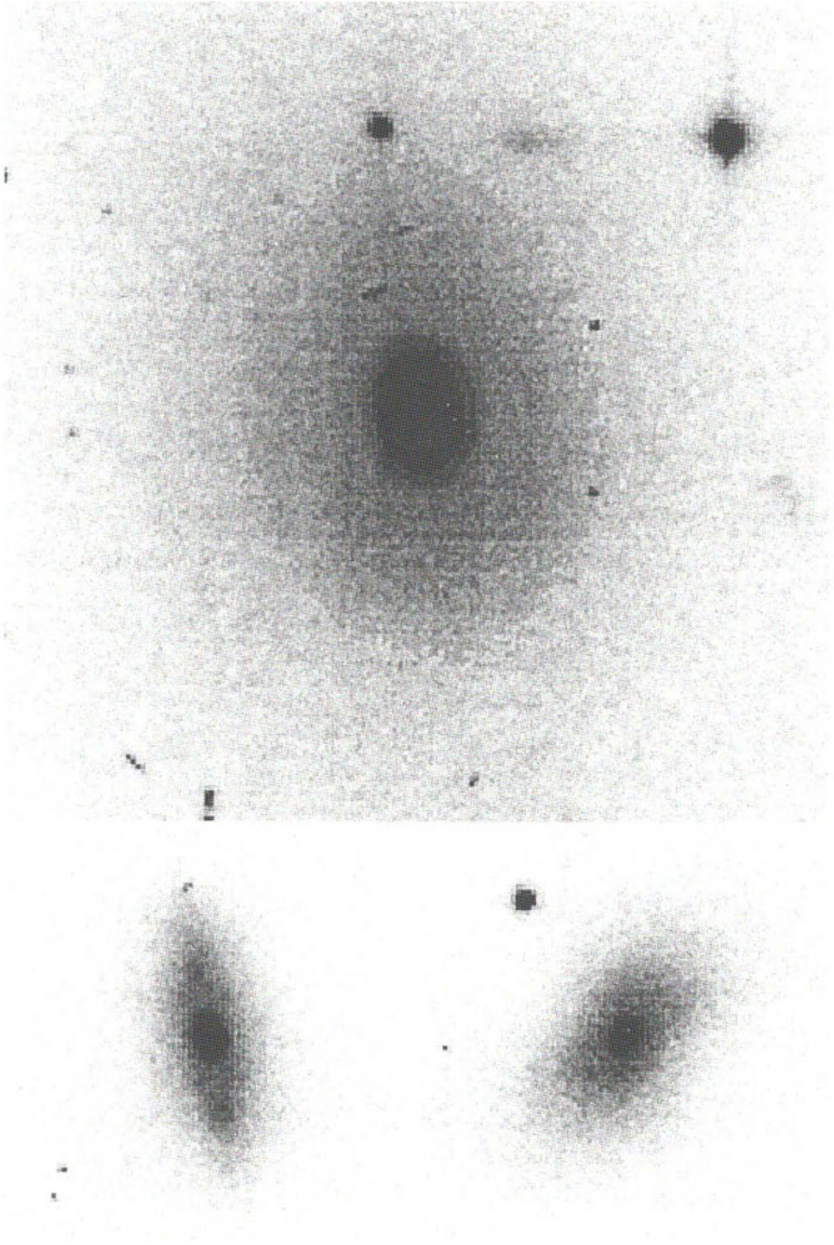
Fig. 1. The three example galaxies - pure E (top), SO (left), boxy E (right). The width of the montage is 32 kpc. North is down and east is to the